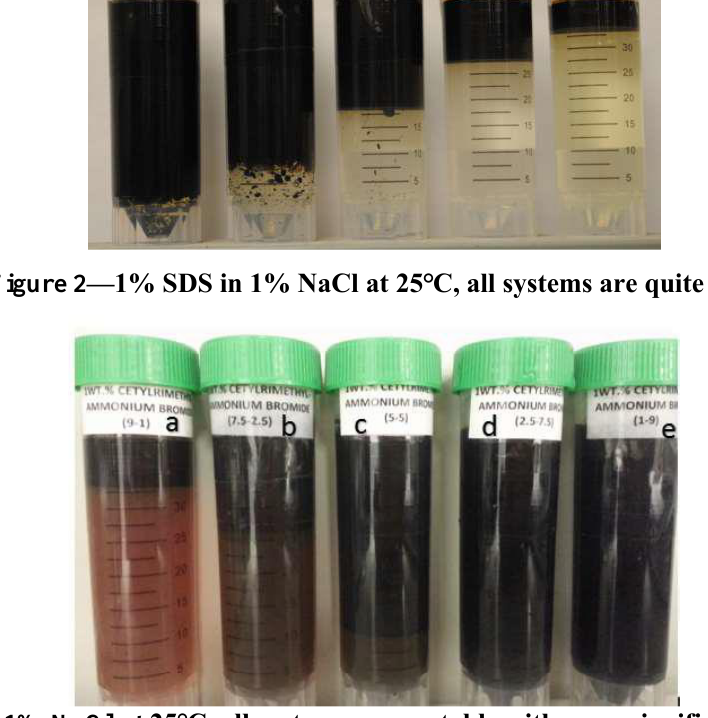
Figure 3—1% CTAB in 1% NaCl at 25℃, all systems are unstable with some significant differences from SDS. The water: oil ratio in this figure has been